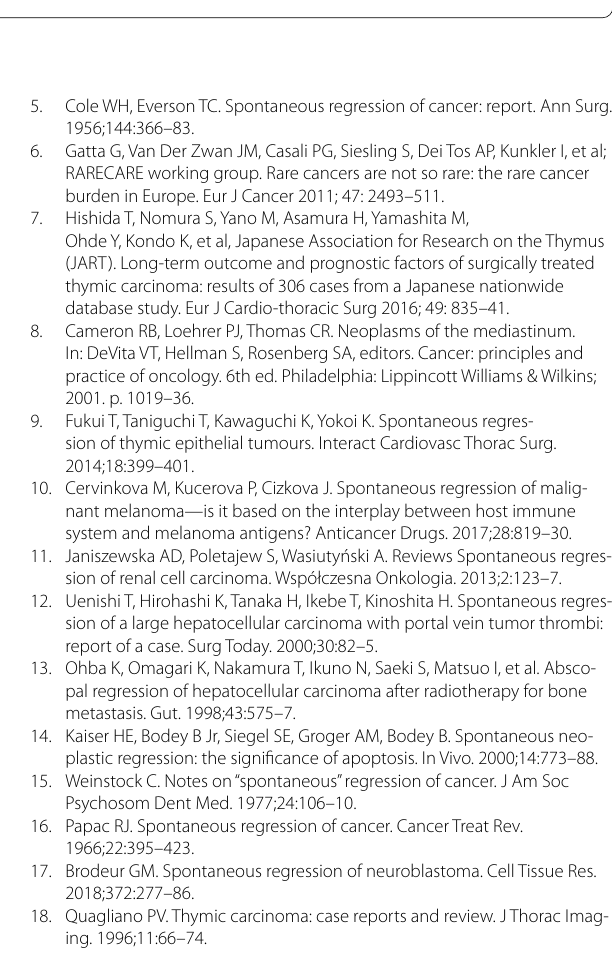
Fig. 3 A Histopathology revealing squamous cell carcinoma of the thymus ( A ) (hematoxylin and eosin stain) and a large necrotic area in the center of the tumor ( B ) (hematoxylin and eosin